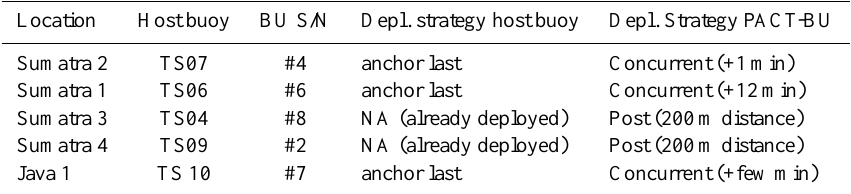
Table 3. Mooring locations, associated equipment and deployment methods. Location Host buoy BU S/N Depl. strategy host buoy Depl. Strategy PACT-BU anchor last Concurrent (+1min) anchor last Concurrent (+12min) #8 NA (already deployed) Post (200m distance) #2 NA (already deployed) Post (200m distance) Java 1 anchor last Concurrent (+few